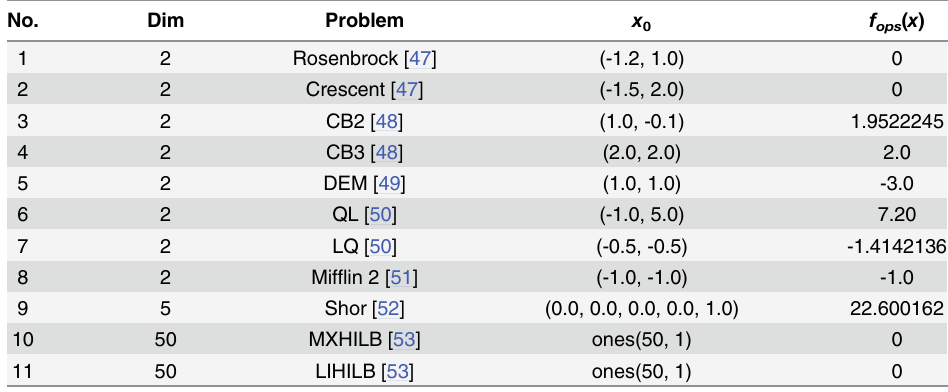
Table 1. Problem descriptions for test